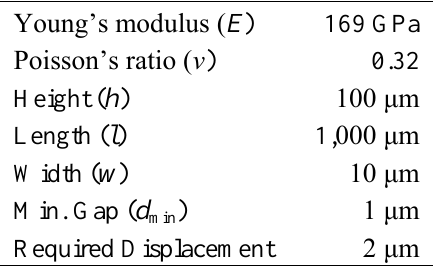
Table 1. Sample problem